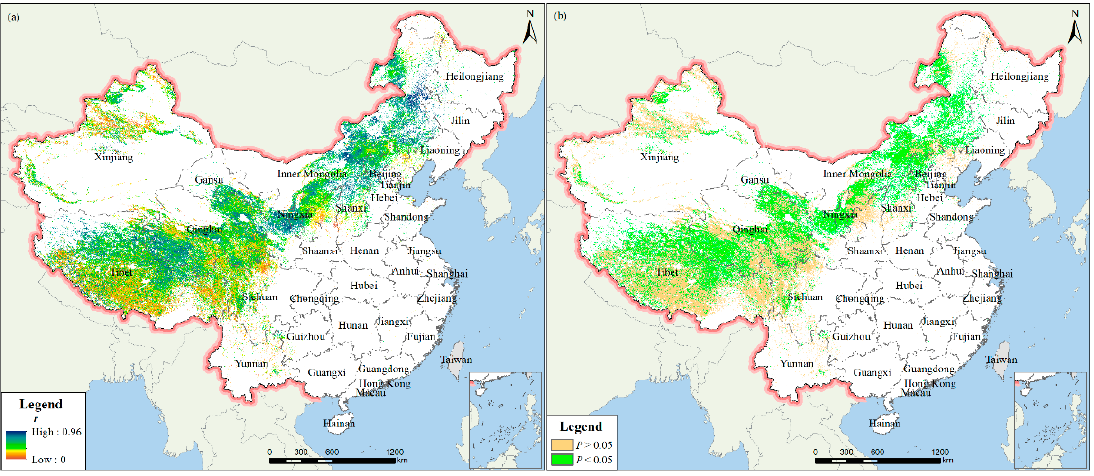
Figure 11. Spatial distribution of ( a ) multiple correlation coefficient between ANPP and annual average temperature and annual average total precipitation and ( b ) the significance level.